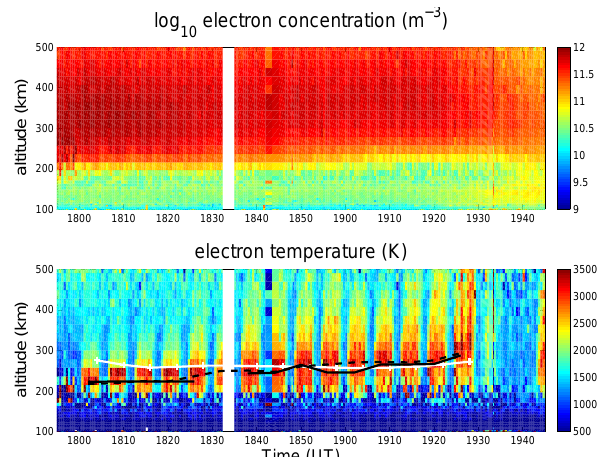
Fig. 1. EISCAT UHF observations of the electron concentration (top panel) and electron temperature (bottom panel). As seen in the top panel the electron concentration in the F region decays steadily, and there are no signs of significant precipitation until 19:30 UT. The electron temperature reaches 3000–3500K for each pulse. For the first pulses the hot ( T e > 2500 K ) region is approximately 50km in altitude extent but gradually the heated region extends to more than 100km. The dashed black line is the approximate upper hy- brid level, the solid black line is the altitude of the maximum tem- perature enhancements and the white line is the altitude where an MSIS model atmosphere gives the same O( 1 D) effective lifetime, as estimated from the DASI 6300 ˚A